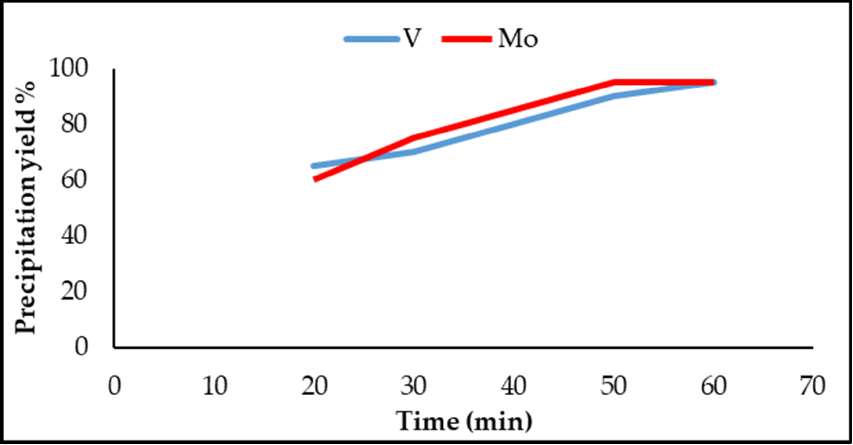
Figure 4 . Precipitation yield of molybdenum and vanadium vs. time (V: pH 9, 40 °C; Mo: pH 1, 90 Figure 4. Precipitation yield of molybdenum and vanadium vs. time (V: pH 9, 40 ◦ C; Mo: pH 1, 90 ◦ °C).